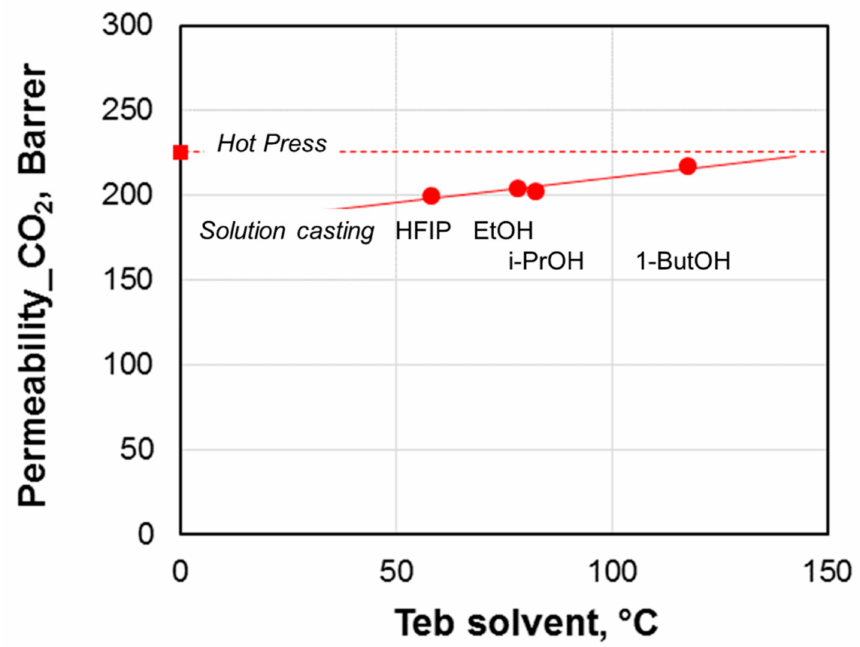
Figure 6. CO 2 permeability in Pebax ® 2533 films produced from different solvents as a function of the solvent boiling point (T0 samples). Circles: data for the films prepared by solvent evaporation; square: data for the film prepared by the hot press method. Lines are guides for the